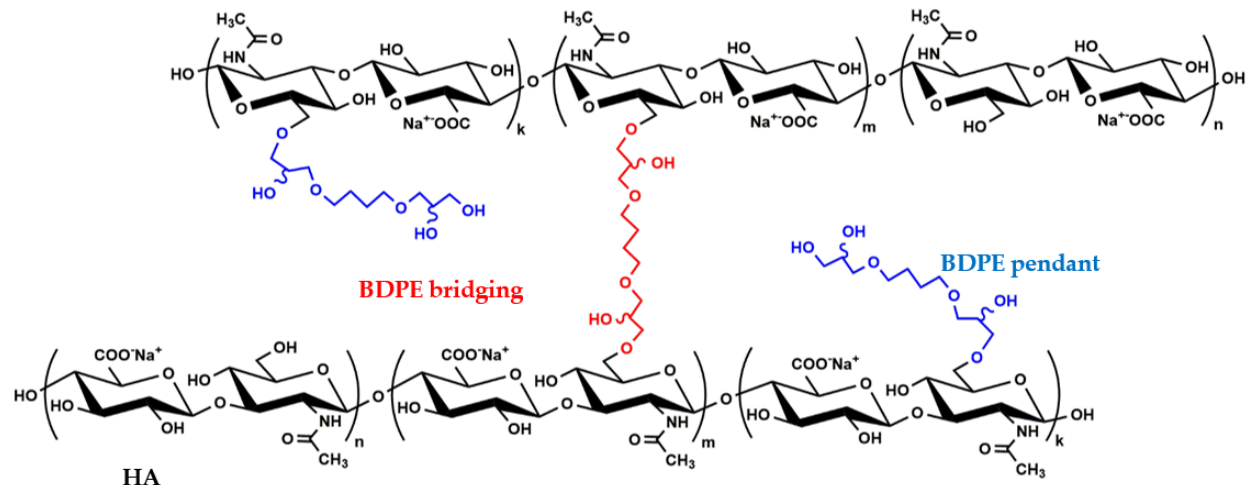
Figure 1. The chemical structure of the HA network formed via the reaction with BDDE. The two resulting 1,4-butanediol di-(propan-2,3-diolyl) ether (BDPE) derivatives are indicated, with BDPE bridging/crosslinking two HA disaccharide units (BDPE bridging, BDPE crosslinking, or double- linked BDPE) in red and BDPE with one side anchored to HA (BDPE pendant; BDPE branching; mono-linked BDPE) in blue. For the sake of simplicity, only the primary hydroxyl functions involved in BDPE linking are depicted, as they are the most reactive and, therefore, the most likely to be modified; nonetheless, the presence of derivatization at any of the secondary hydroxyls cannot be ruled out. The disaccharide units crosslinked by BDPE will be referred to as crosslinked HA d ; the disaccharide units bearing BDPE pendant will be referred to as branched HA d .